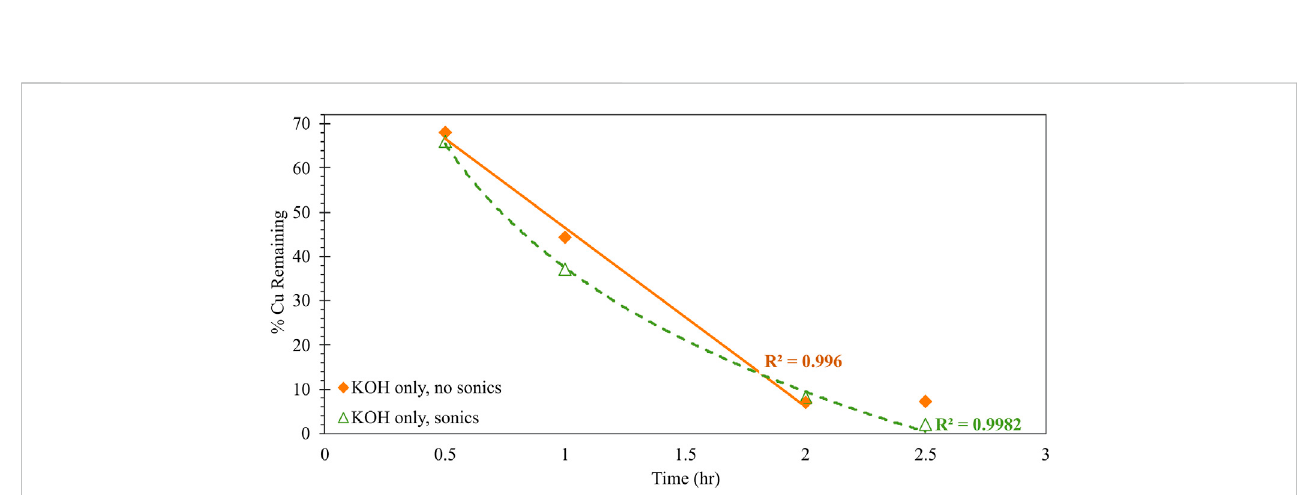
FIGURE 3 Impacts of sonication on the kinetic behavior of alkaline (0.1 M KOH) Cu 0 corrosion, reported as the percentage of initial Cu added that is not bound to DTPA in solution. Condition of no sonication is indicated with solid orange diamonds; condition of sonication is indicated with open green triangles. Trendlines (solid for no sonication; dashed for sonication) are linear ( R 2 = 0.996) and logarithmic ( R 2 = 0.998) best- fi ts for the no-sonication and sonication conditions,